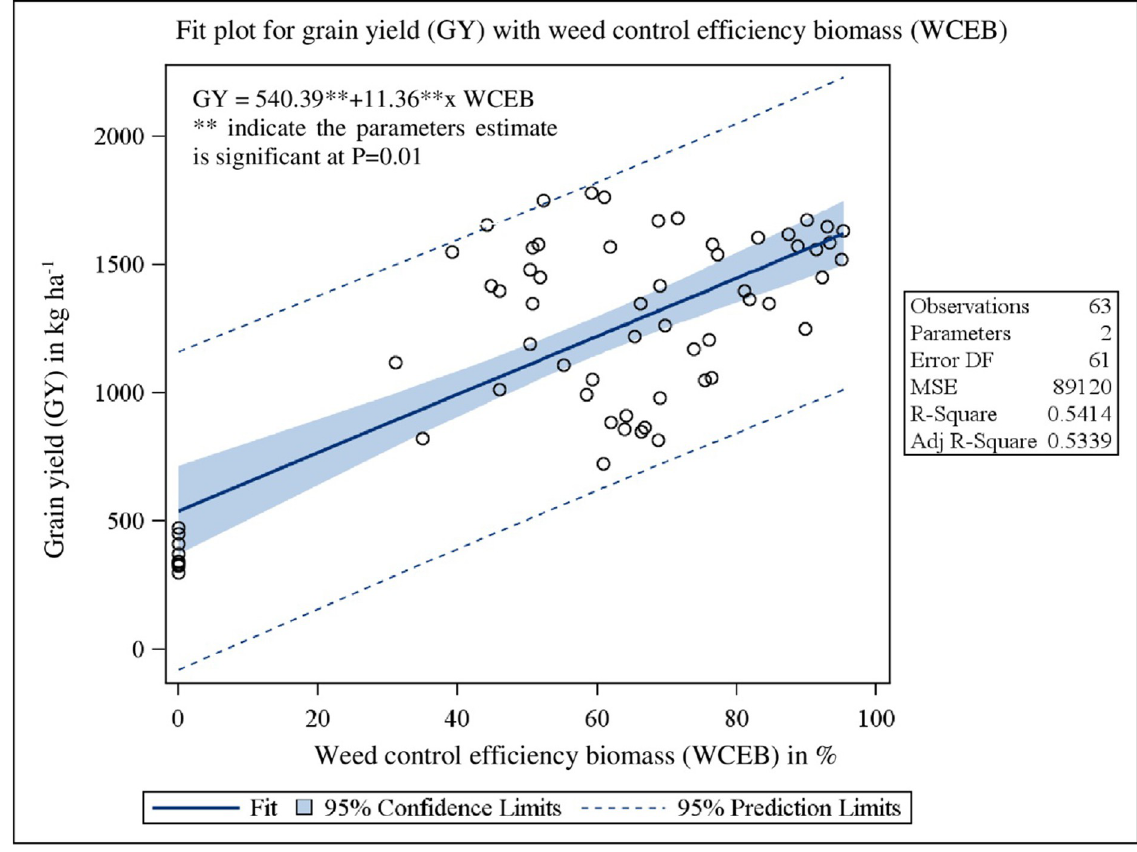
Fig 1. Relationship between grain yield (GY) and weed control efficiency biomass (WCEB) under herbicidal weed management practices in